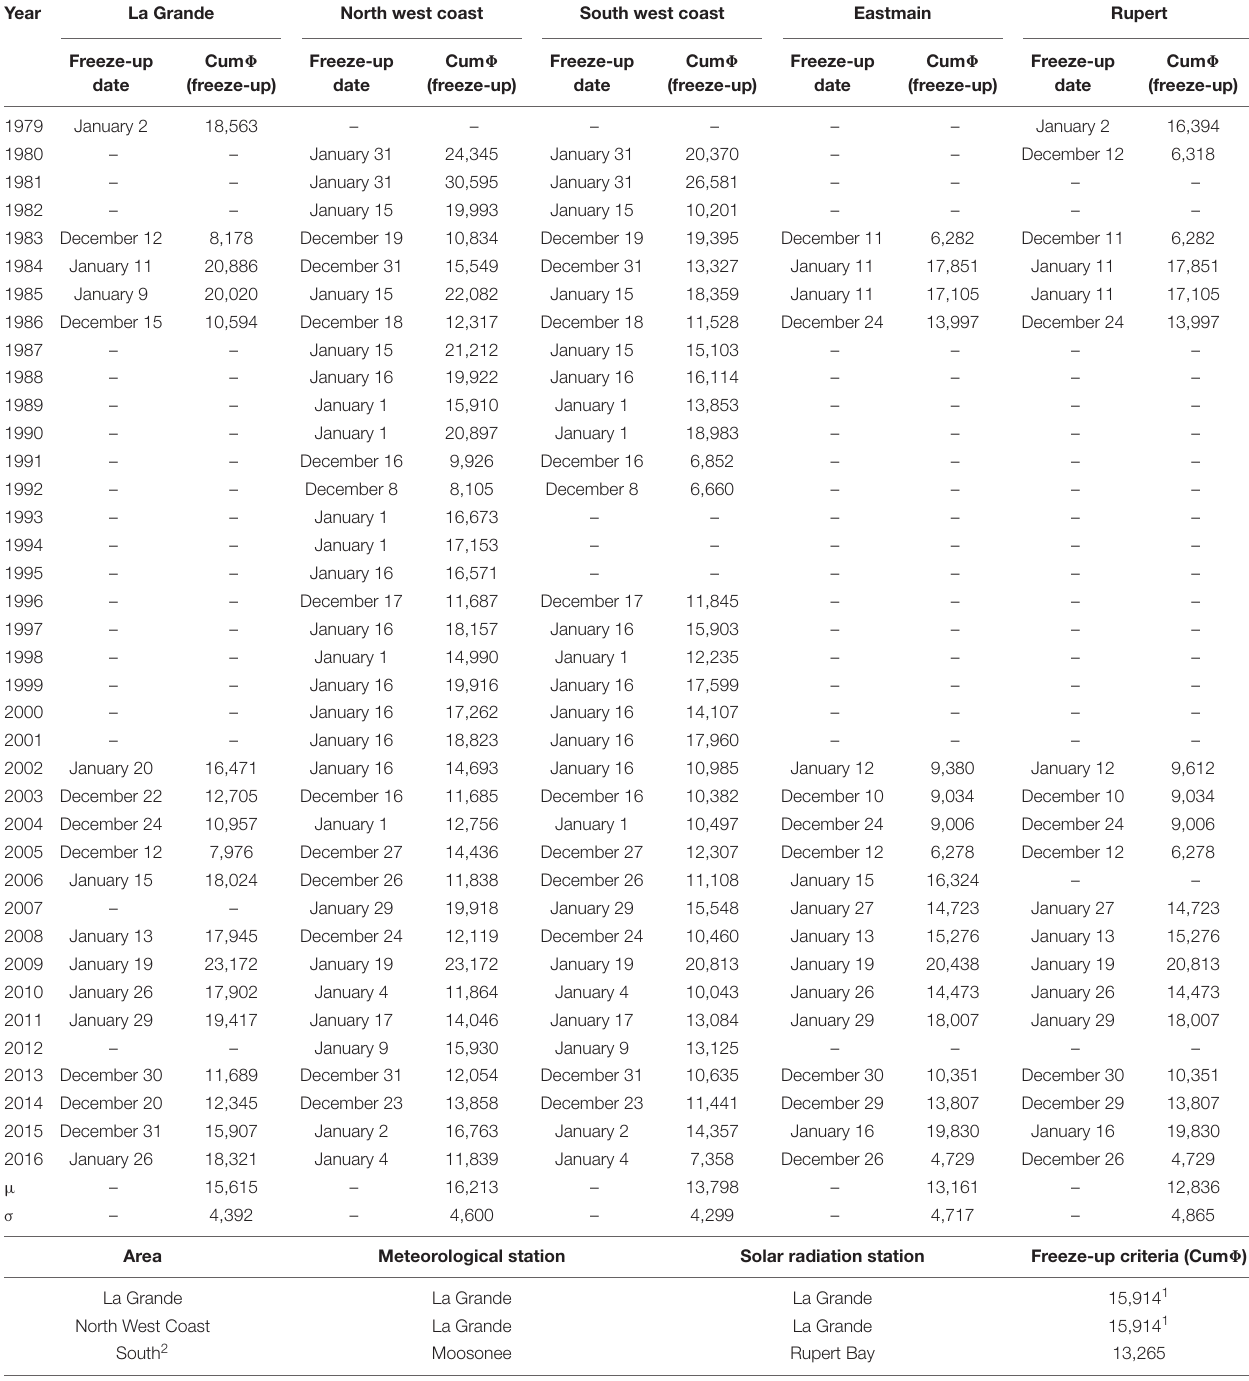
TABLE 1 | Freeze-up criteria in James